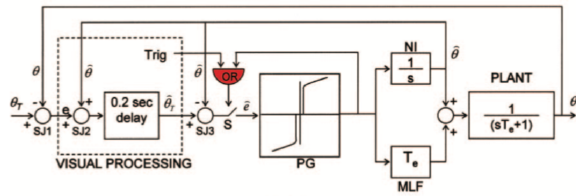
Figure 2. Typical incorporation of Robinson’s pulse generator (PG) and neural integrator (NI) into a model of saccadic eye movements. . MLF, medial longitudinal fasciculus. From (Ramat et al., 2007).